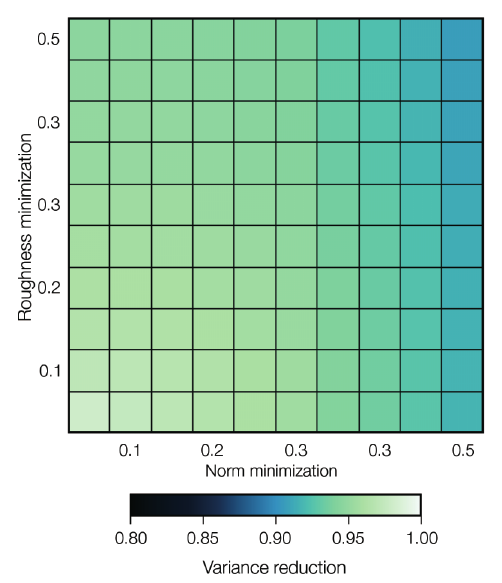
Fig. 7. Inversions of the 35 s Love wave Harvard database: variance reduction as a function of norm ( x -axis) and roughness ( y -axis) damping